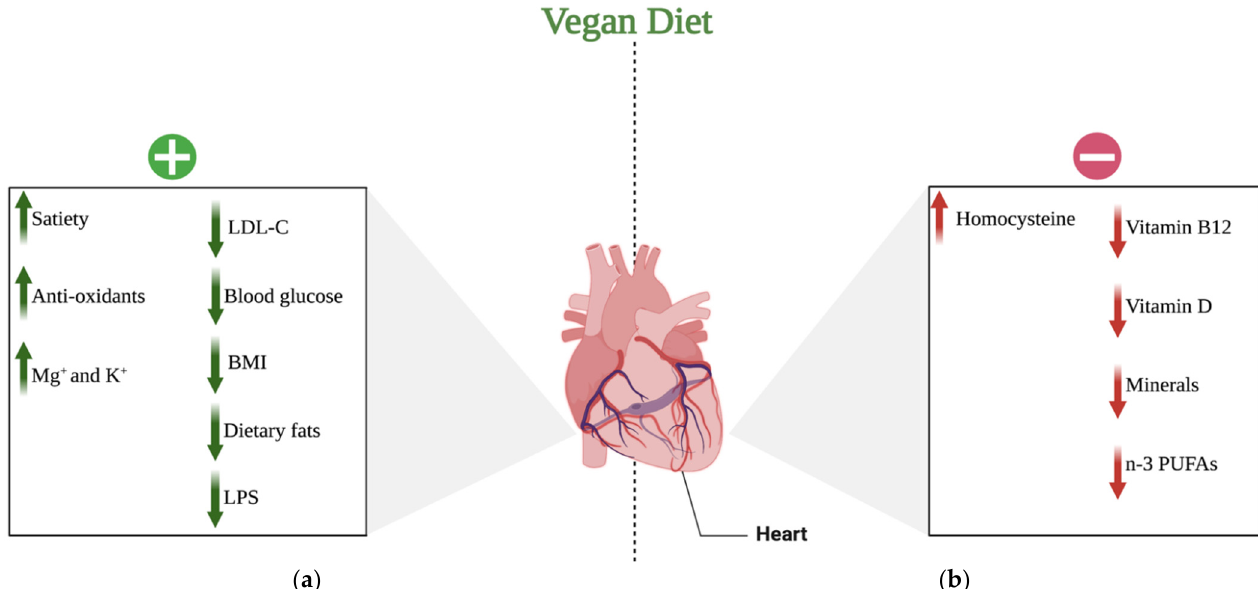
Figure 2. Potential effects of a vegan diet on the cardiovascular system: ( a ) positive effects of a vegan diet on the cardiovascular system; ( b ) negative effects of a vegan diet on the cardiovascular system. Abbreviations: (+) positive; ( − ) negative; ↑ increase; ↓ decrease; LDL-C—low-density lipoprotein-